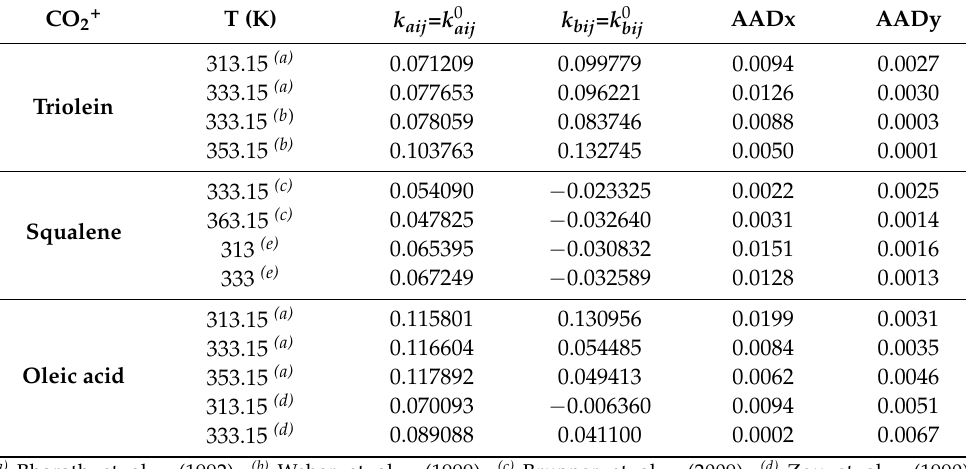
and k bj = k 0 adjusted with experimental phase equilibrium aij bij